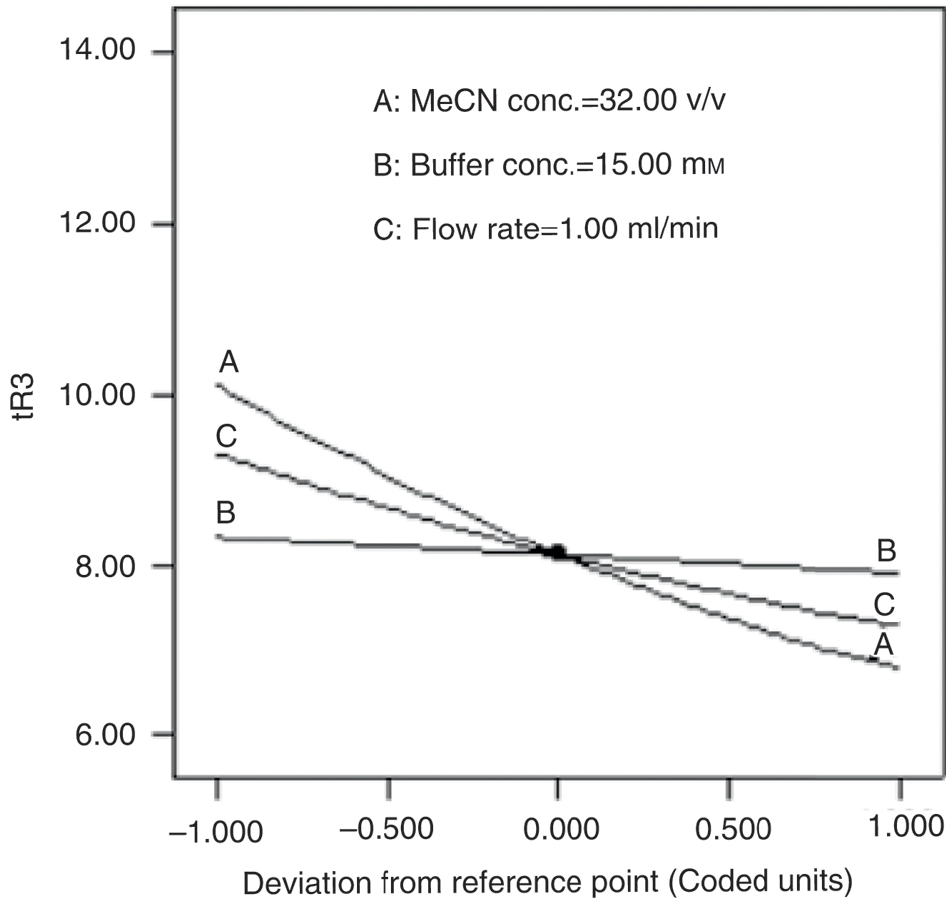
Figure 12: Perturbation plot generated for the optimization of resolution between critical pairs in chromatography depicting sensitivity of response toward variations in variables (Sivakumar et al. 2007).